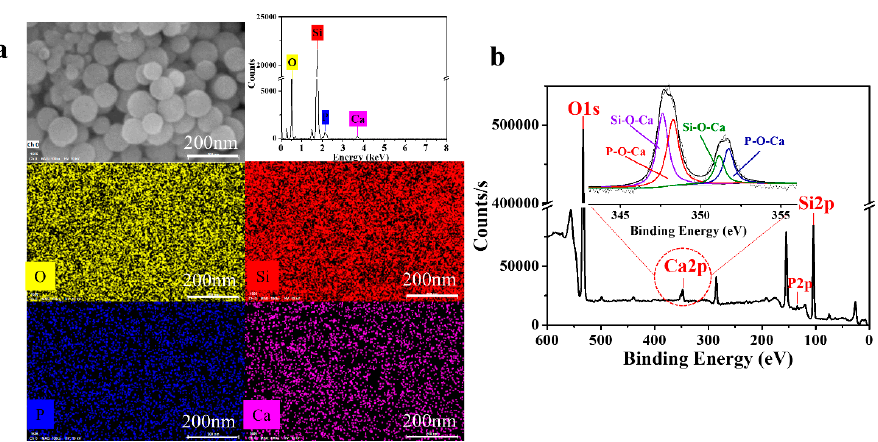
Figure 6. ( a ) Element mappings of O, Si, P and Ca in MSCNs and EDS results of the MSCNs. ( b ) XPS spectra of MSCNs (inset image: high-resolution XPS spectrum of Ca 2p region of the MSCNs).